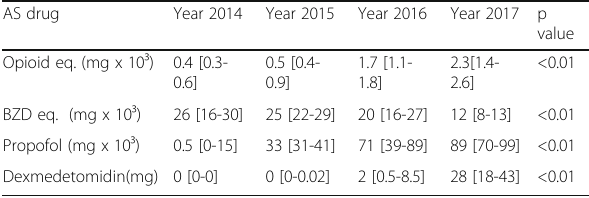
Table 1 (abstract 000959). Consumption profile of AS drugs (expressed as mg/100 occupied bed